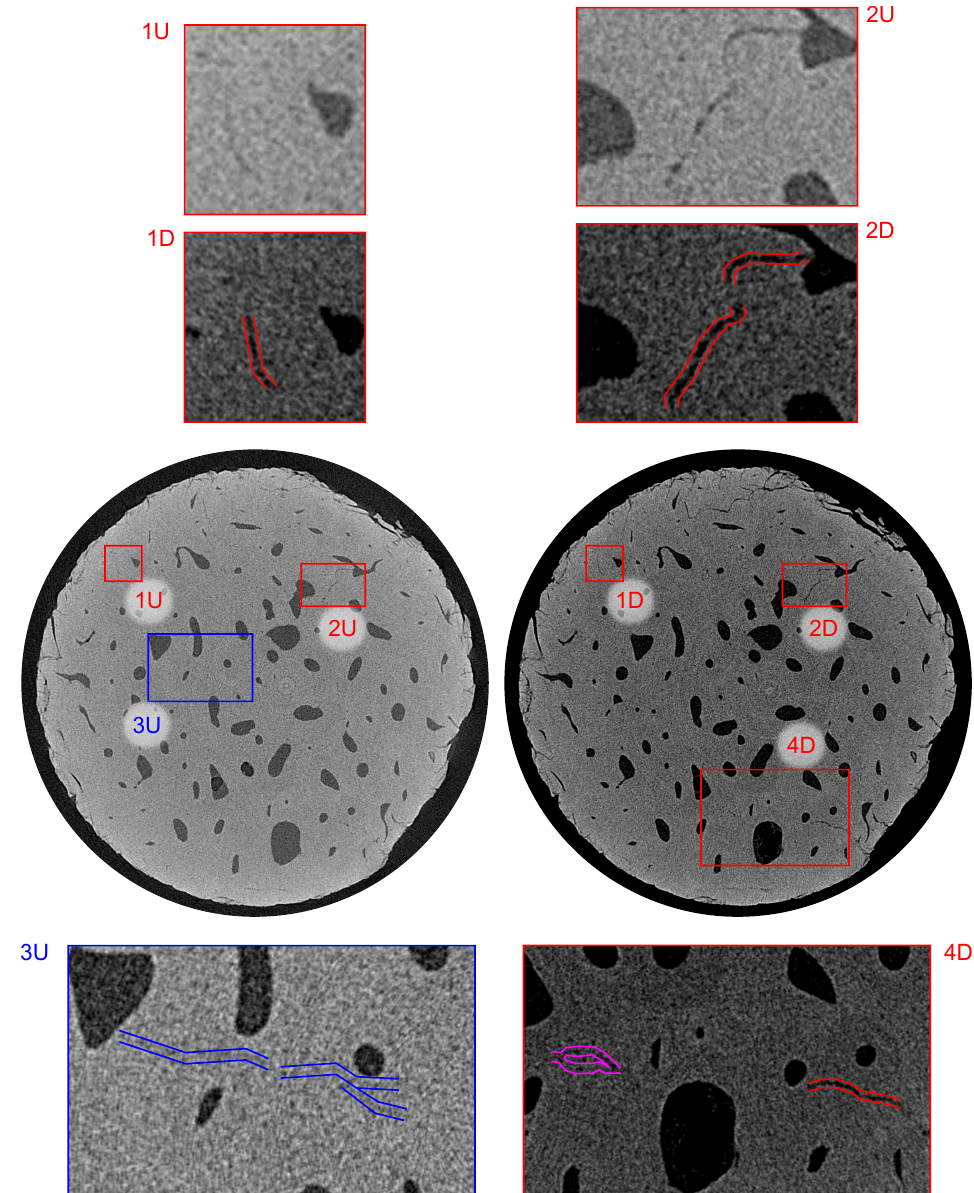
Figure 10. Visualization of the reconstructed 3D volumes—transverse plane at a distance of 2.02mm from the upper loading platen. Index “U” stands for the intact (unloaded) state and “D” stands for the loaded (damaged) state. The blue color depicts the small microcrack present in the intact state, the purple color depicts the microcrack formed by the fatigue loading, and the red color depicts the microcracks with increased dimensions as a result of the loading